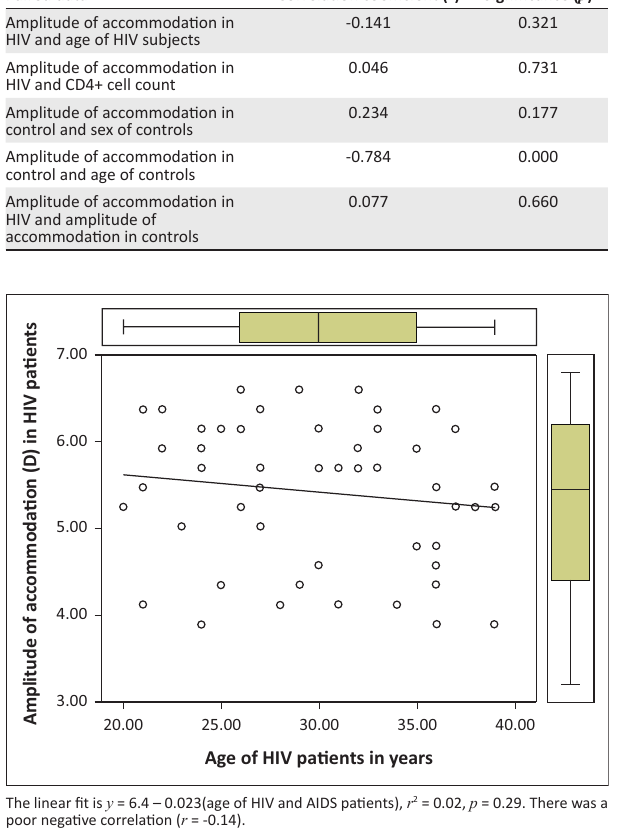
TABLE 2: Correlation coefficients for the variables in the measurement of subjective amplitudes of accommodation in HIV and AIDS and controls. Paired data